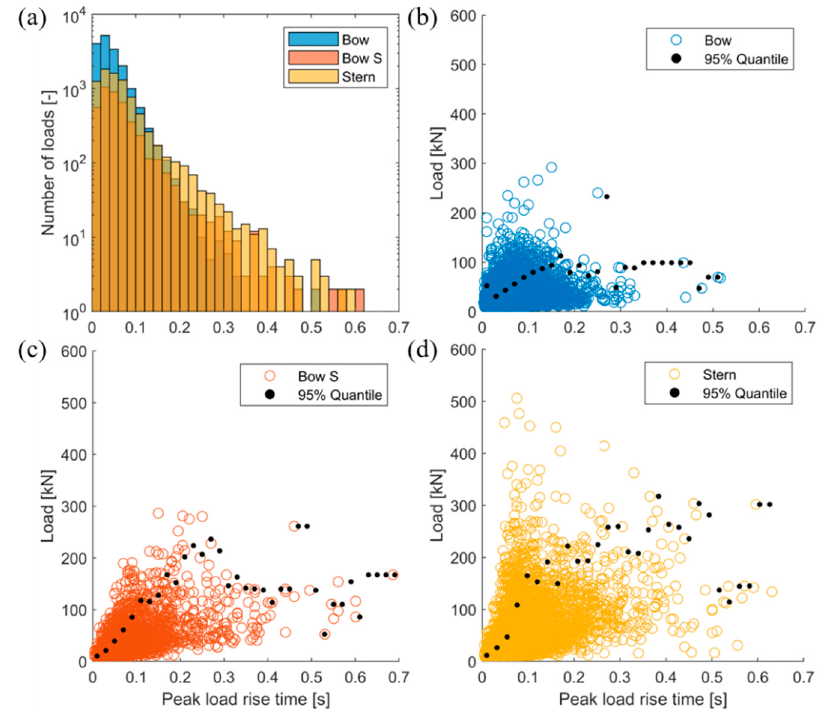
Figure 13. Peak load rise times from all the tests at ( a ) all hull regions in histogram format, and individual loads with calculated 95% quantiles at ( b ) bow, ( c ) bow shoulder, and ( d ) stern shoulder.